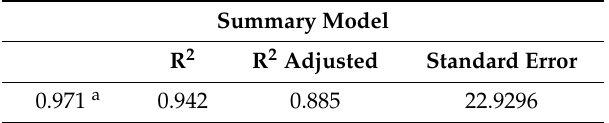
Table 14. Determination coe ffi cients: Wheel-tracking test and second modulus of the plate bearing test. test.